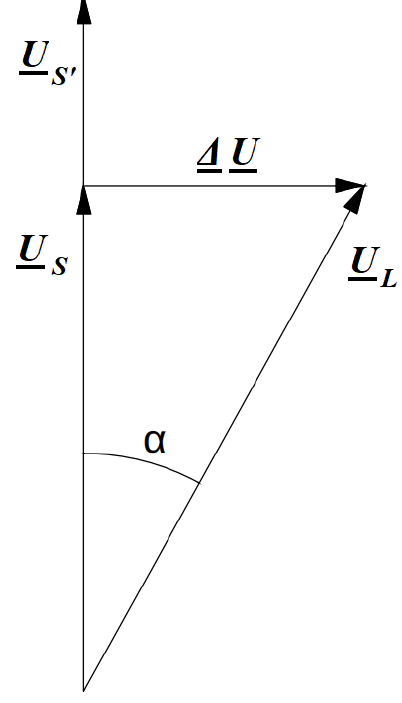
Figure 6. ACPST voltage phasor diagram.